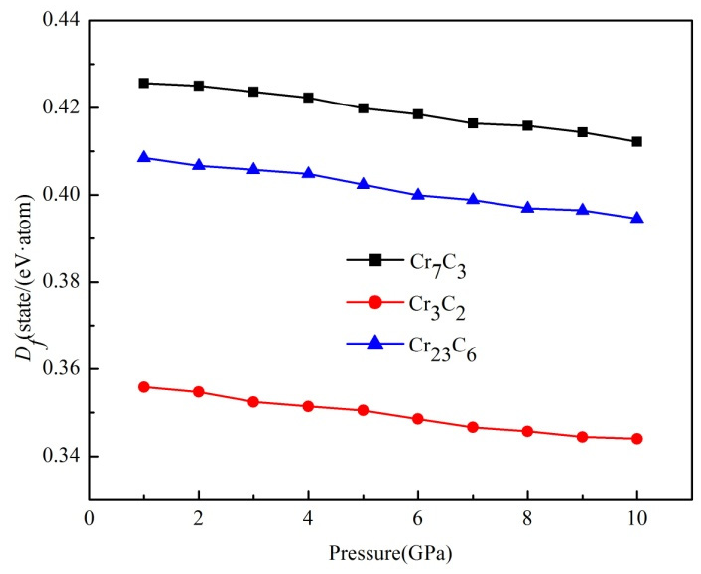
Figure 5. The value of the total DOS at Fermi level N ( D f ) decreases under pressure.